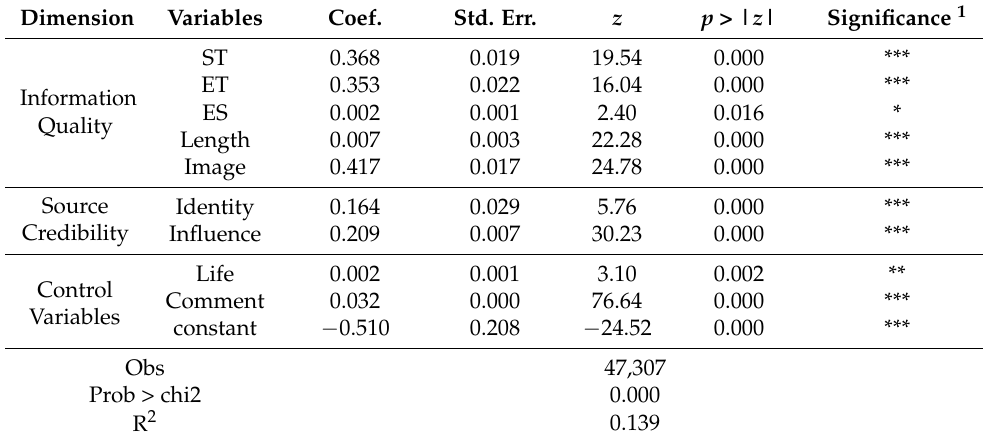
Table 4. Model validation and hypothesis